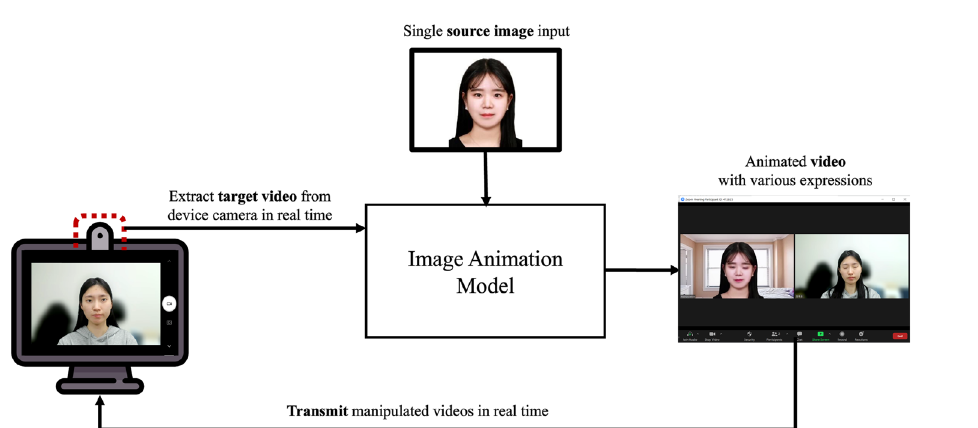
Figure 9. An architecture for demonstration in Zoom.